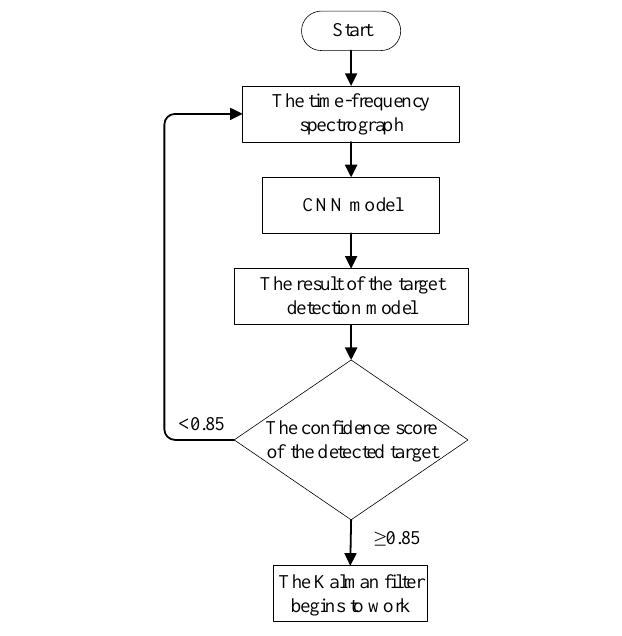
Figure 6. The flowchart of the target detection model.